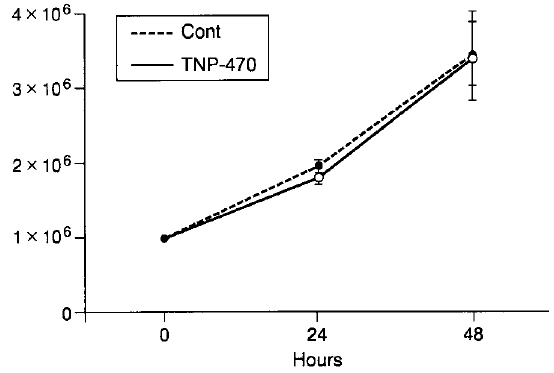
Fig. 2. The effects of TNP-470 on the proliferation of HT1080 cells. HT1080 cells were incubated with TNP-470 (10 ng/ml) for 48 hrs. Cells were counted using hemocytometer. Data are means from 3 independent experiments ±